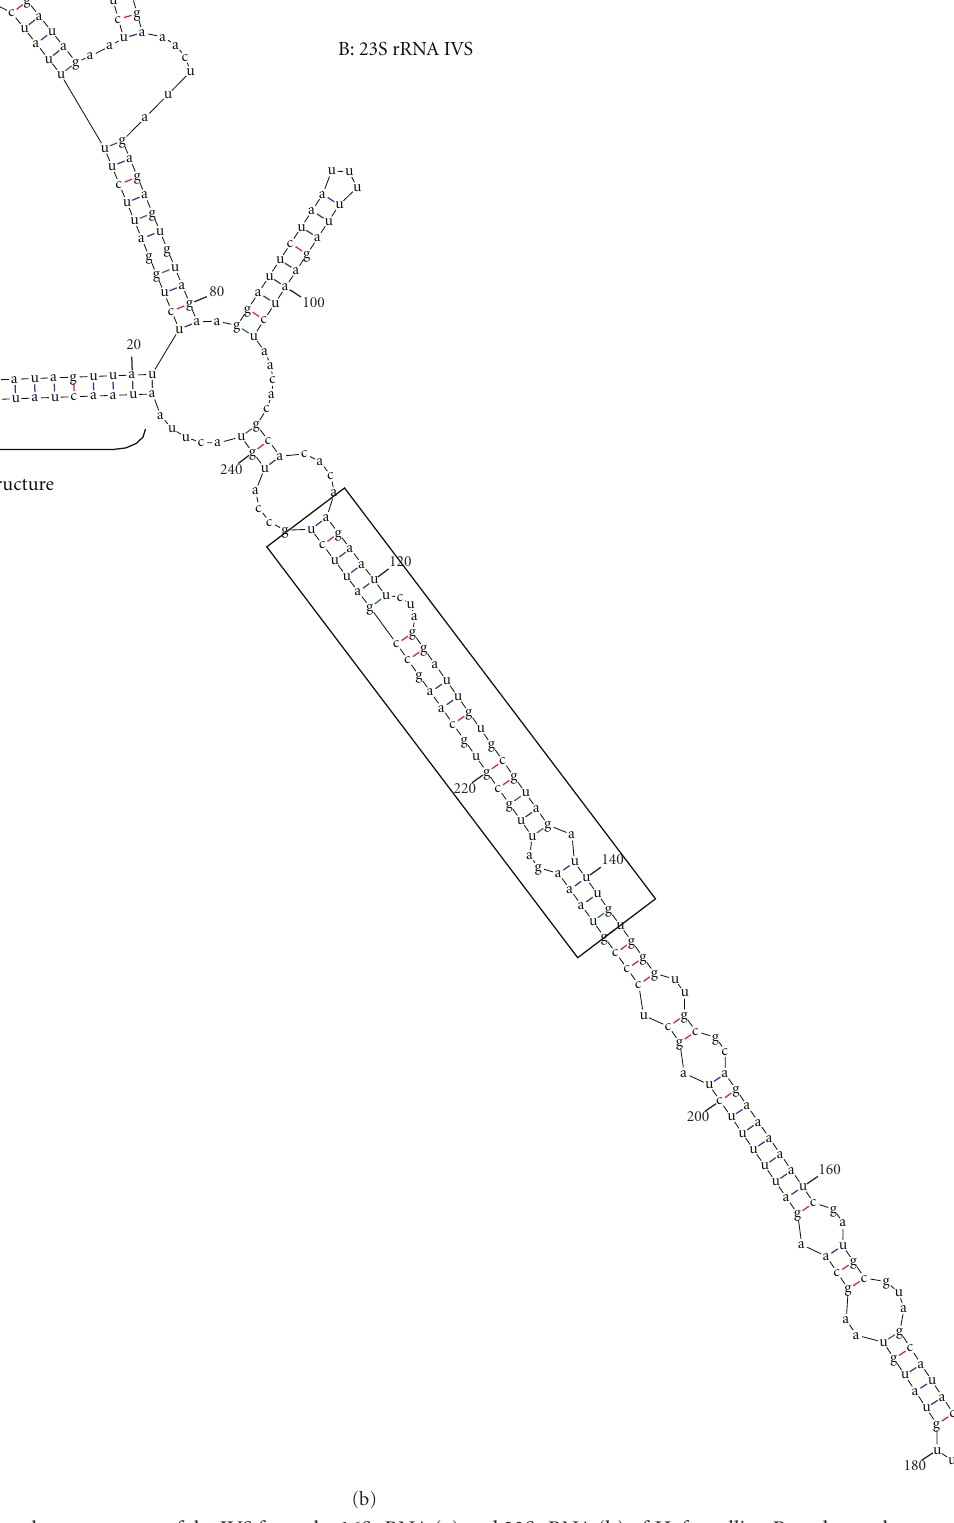
Figure 3: Predicted RNA secondary structures of the IVS from the 16S rRNA (a) and 23S rRNA (b) of H. fennelliae. Boxed area shows region of homology between the 2 IVS